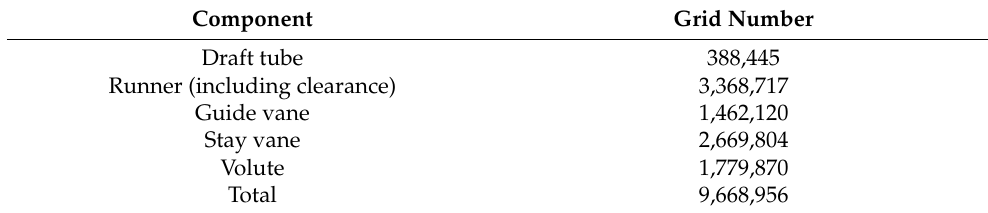
Table 2. Grid number of each